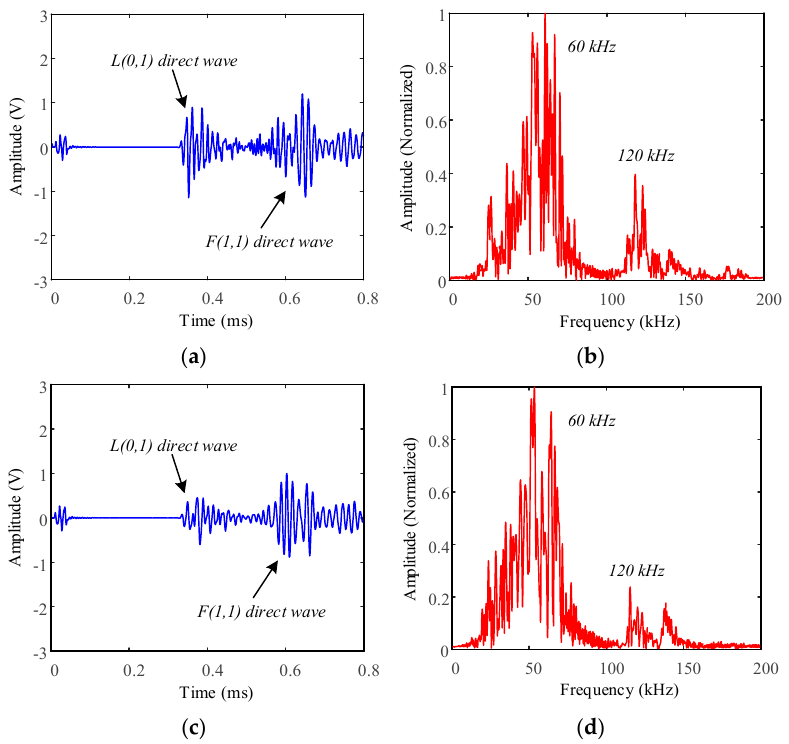
Figure 13. The wave signals and FFT spectrum for the two contact wires with an exciting center frequency of 60 kHz: ( a ) the time domain signal of the active wire, ( b ) the FFT spectrum of the active wire, ( c ) the time domain signal of the passive wire, and ( d ) the FFT spectrum of the passive wire.